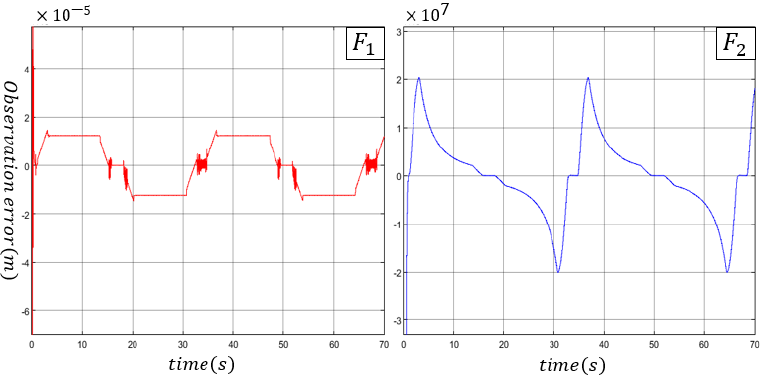
Figure 6. Observation error of 𝐹 1 and 𝐹 2 .